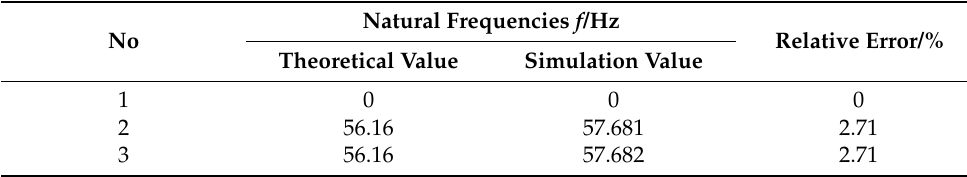
Table 3. Comparison of theoretical and simulation results of the natural frequencies.